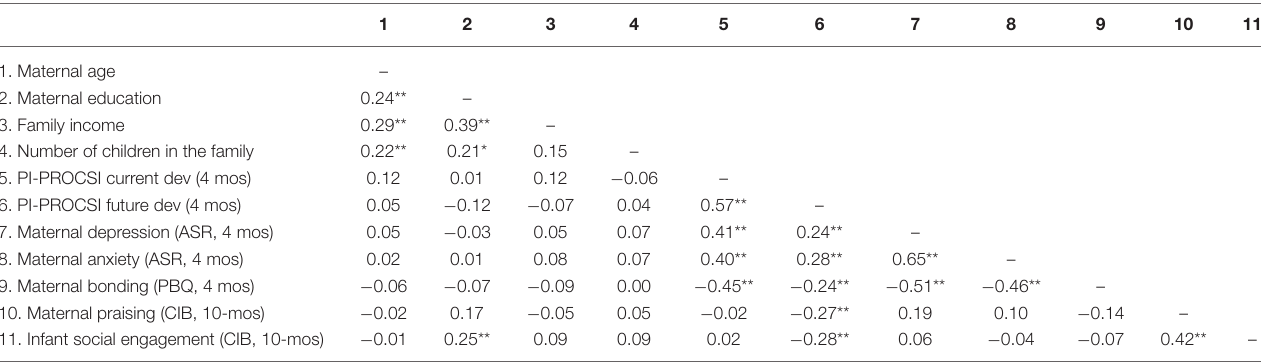
TABLE 1 | Correlations matrix between demographic variables, PI-ROCD (PI-PROCSI current and future development), maternal depression and anxiety (ASR), maternal bonding (PBQ), and maternal praising and infant social engagement